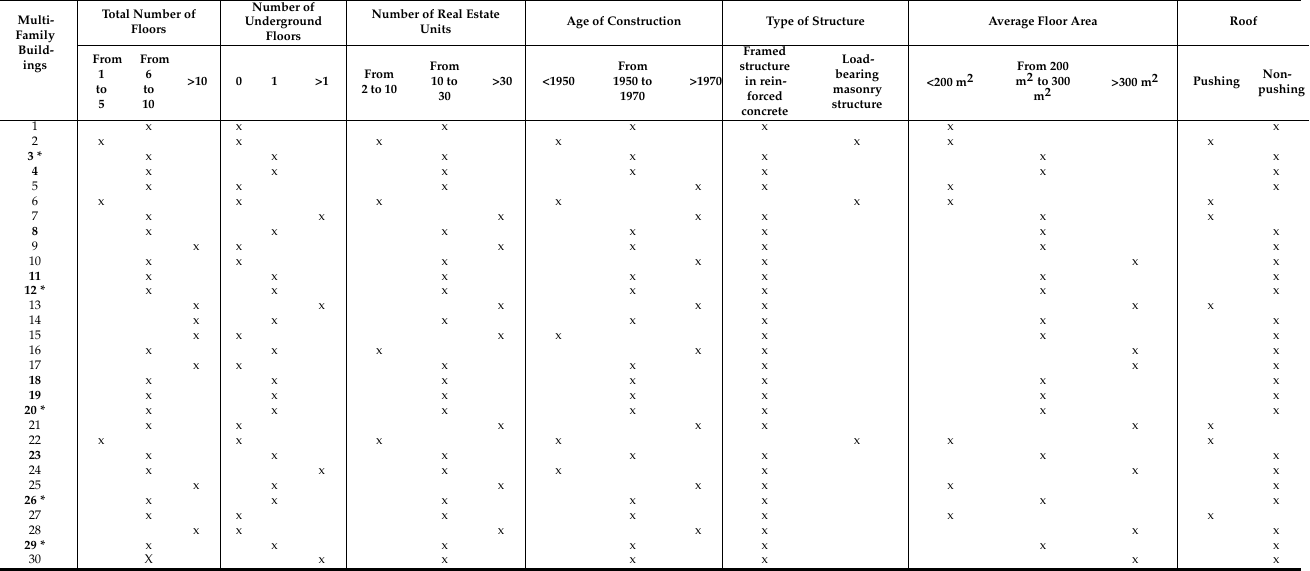
Table A1. Classification of multi-family buildings, identification of the most common features, and selection of the representative